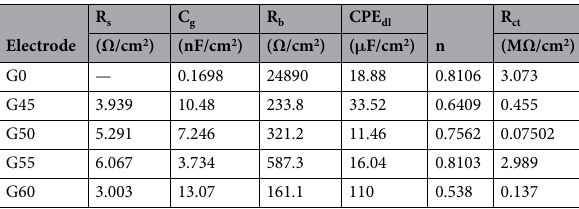
Table 1. Equivalent circuit parameters of all